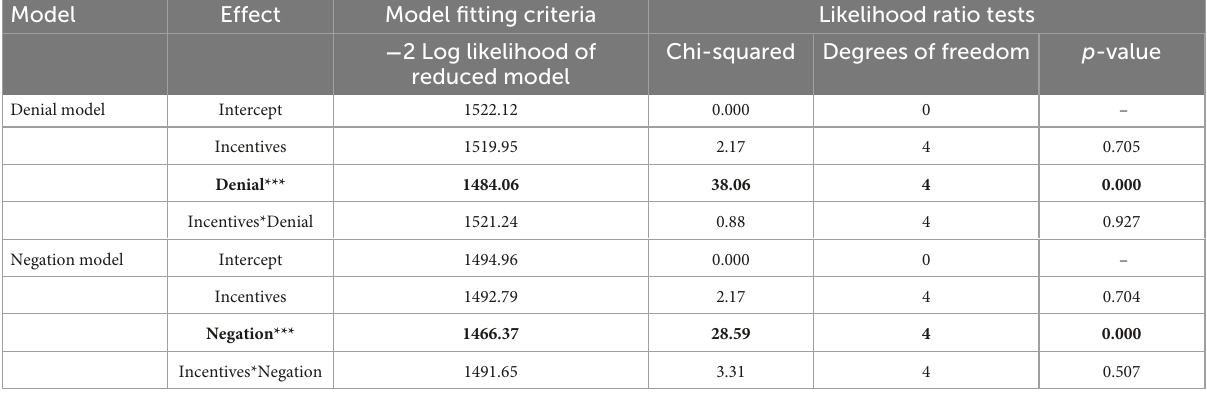
TABLE 4 Effects of the “incentives”, “denial” and “negation” factors on participants’ responses to the interpretation question in the multilevel multinomial regression denial model and negation model.